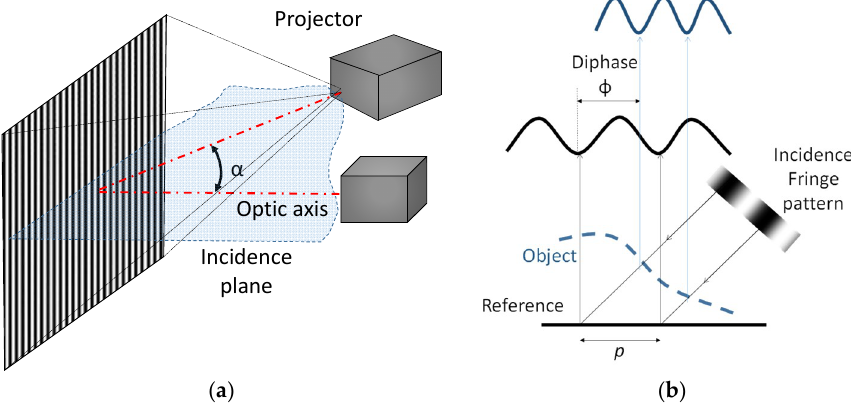
Figure 1 . ( a ) Fringe projection schematic set-up; ( b ) illustration showing the physical principle of the fringe projection technique.